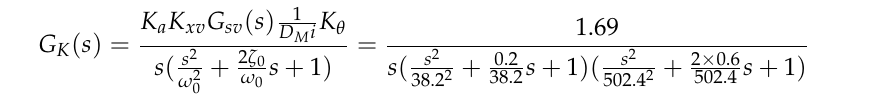
Figure 9. Simplified angle control block diagram of the heading angle adjustment circuit.